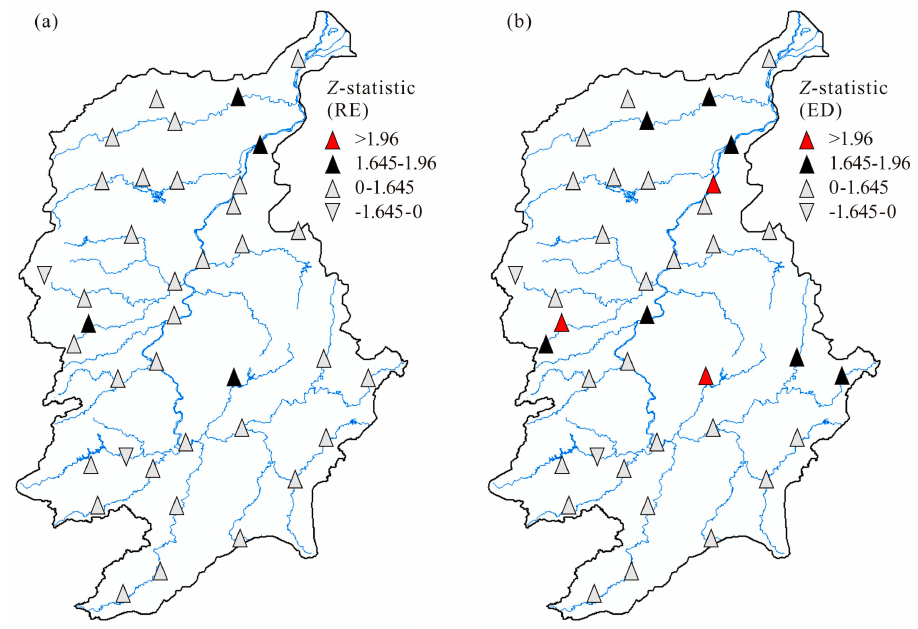
Figure 9. Spatial patterns of the long-term trends of ( a ) annual rainfall erosivity and ( b ) erosivity Figure density.